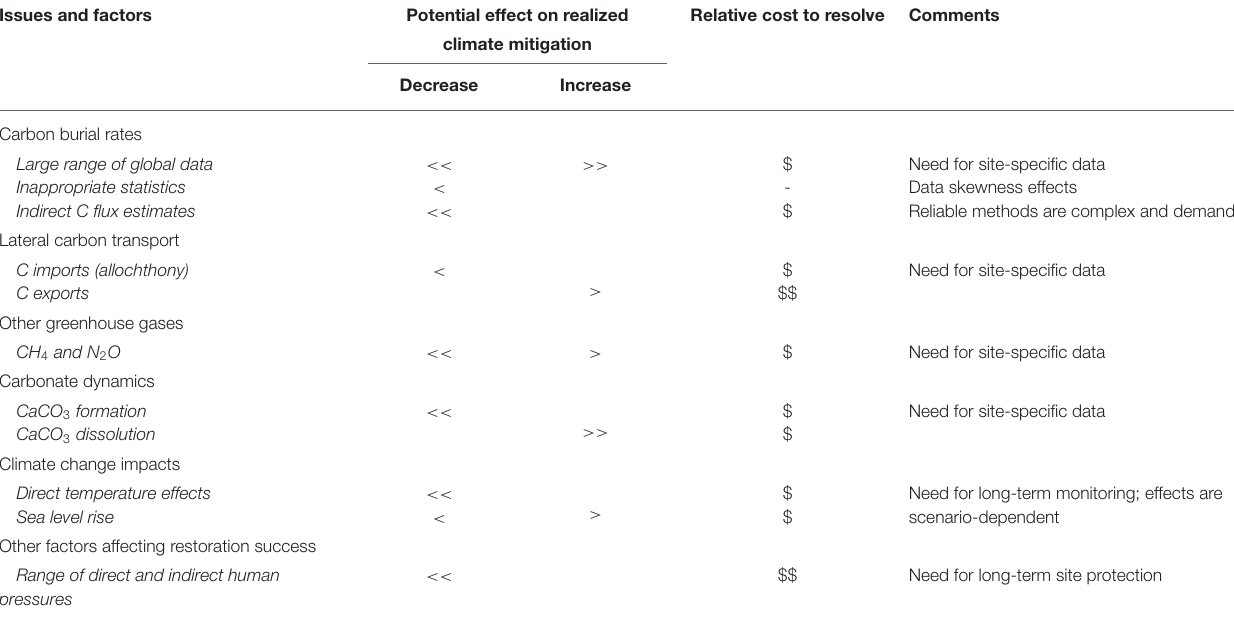
TABLE 2 | Summary of biogeochemical issues affecting the reliability of using CBCE restoration for climate